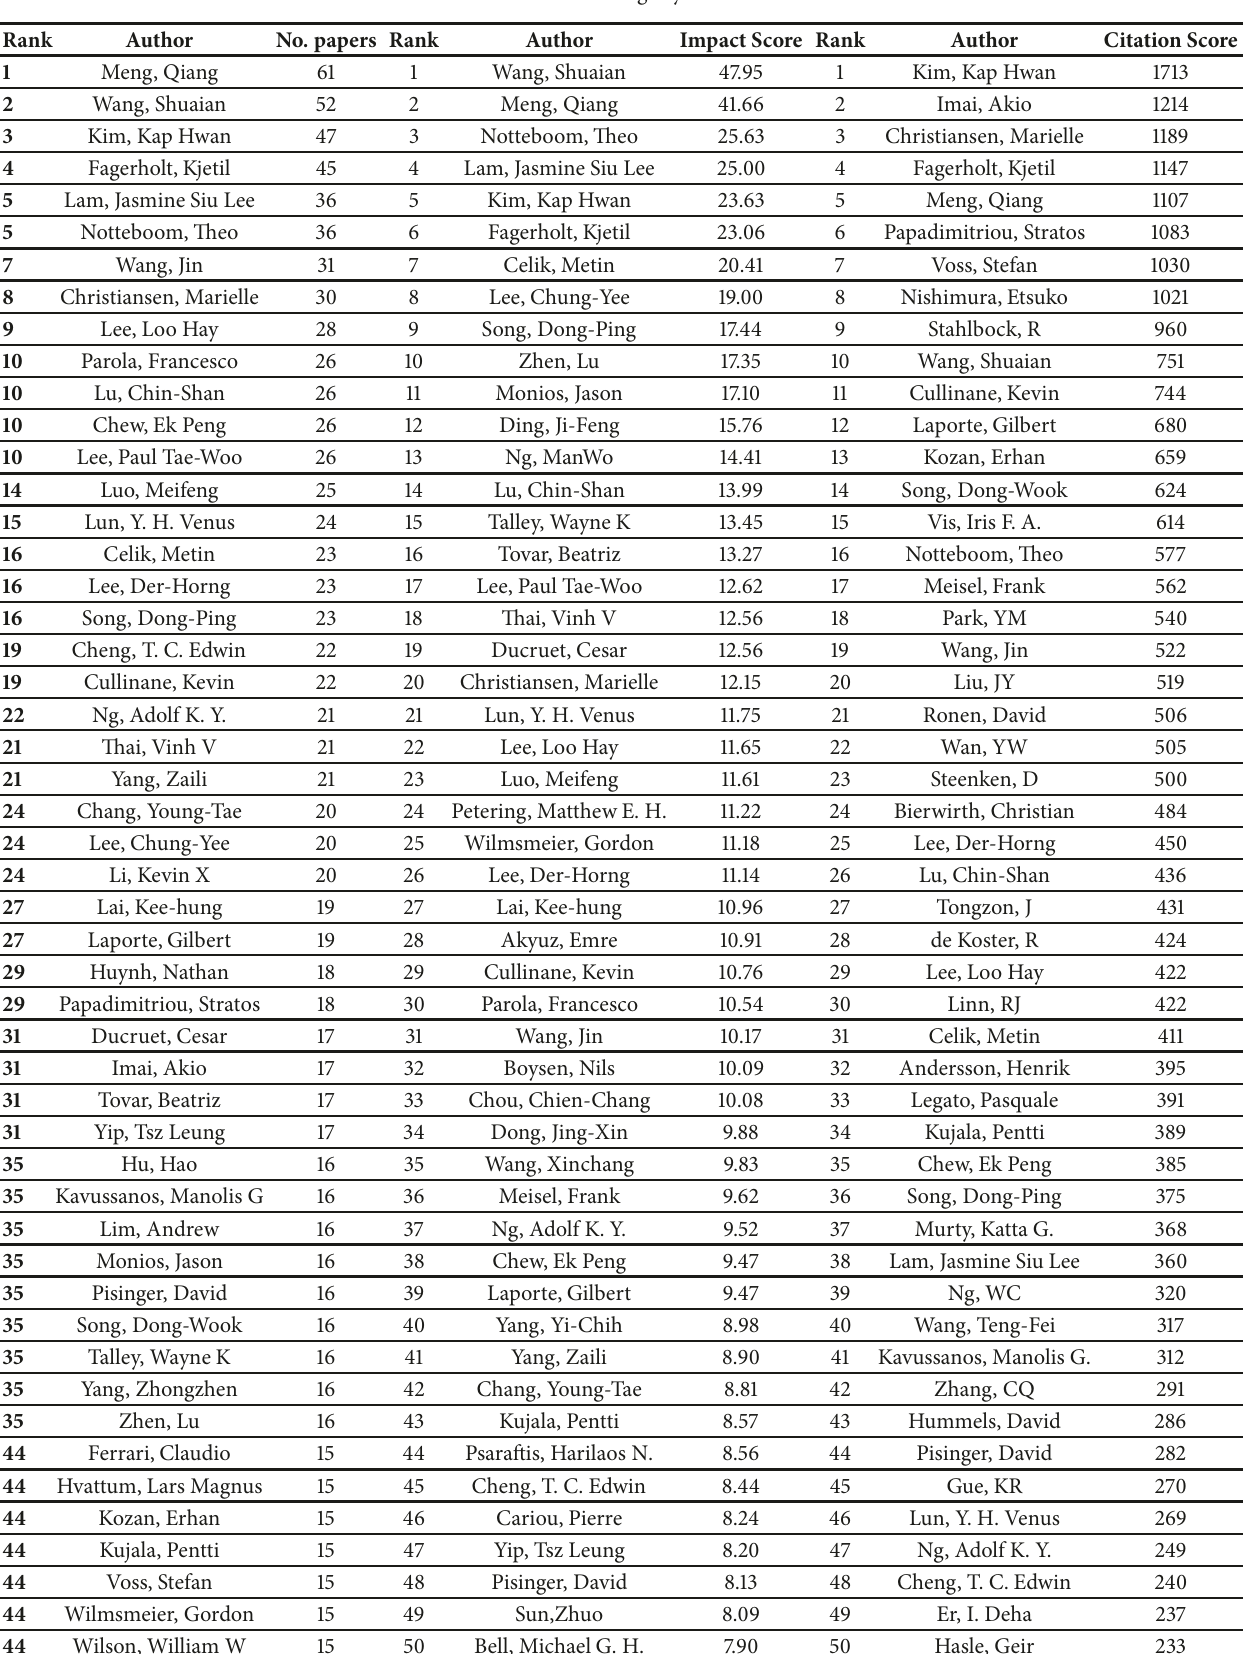
Table 2: Rankings by